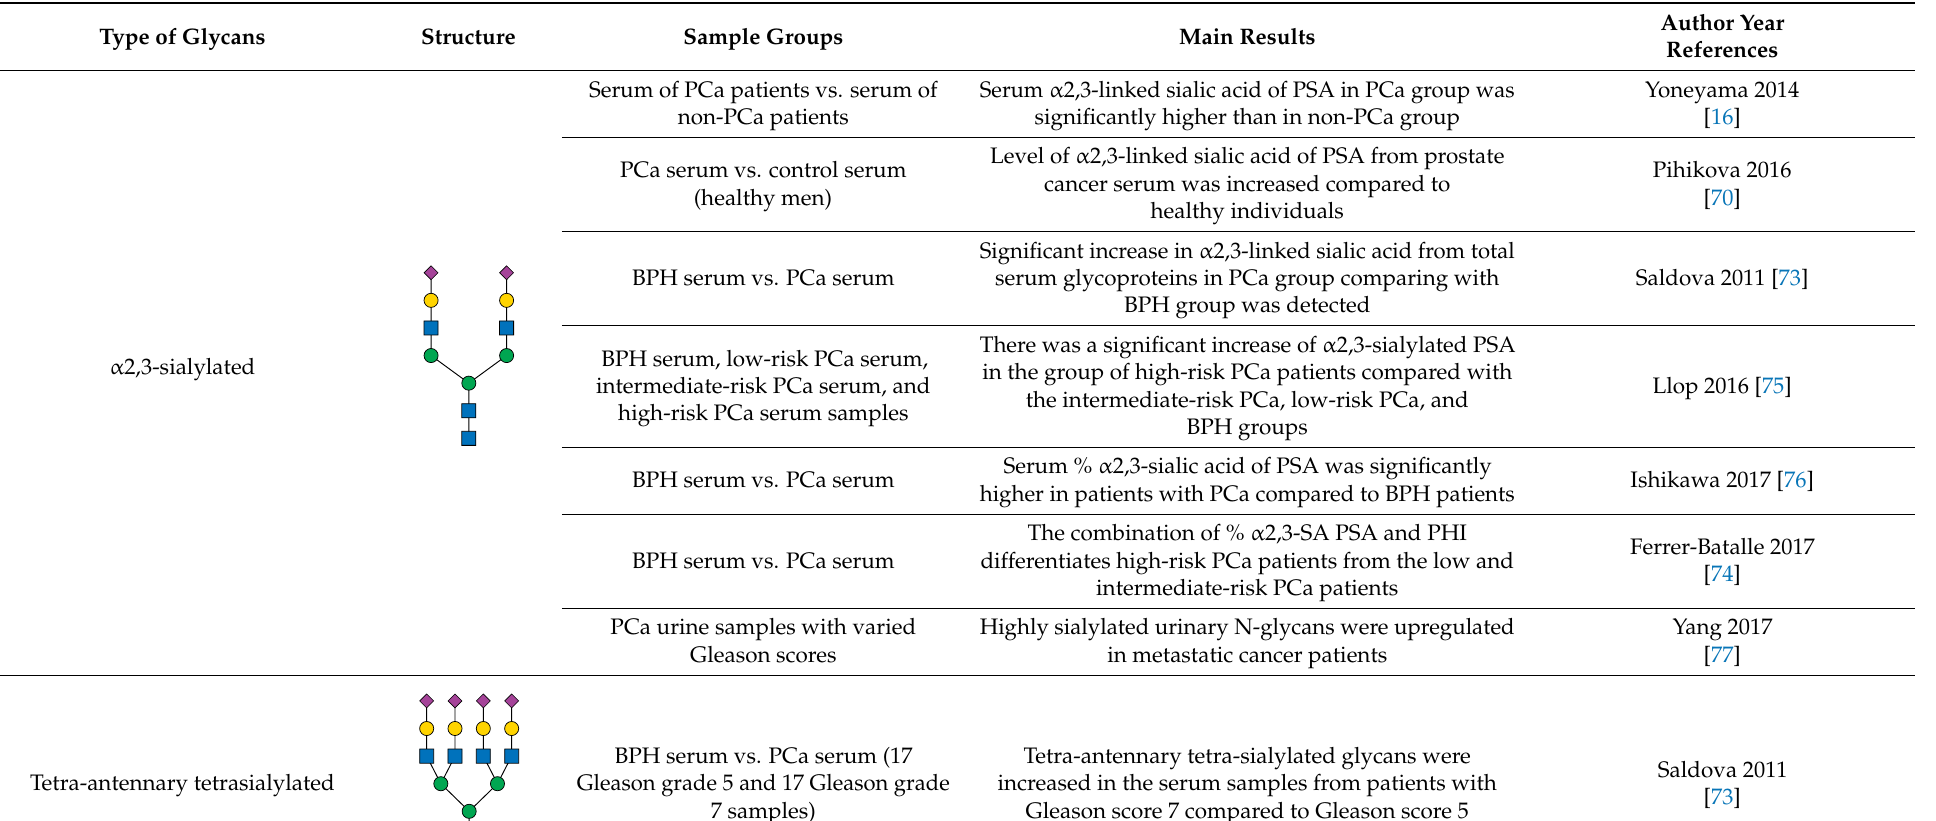
Table 1. Summary of sialylated N-glycan alterations in prostate cancer.